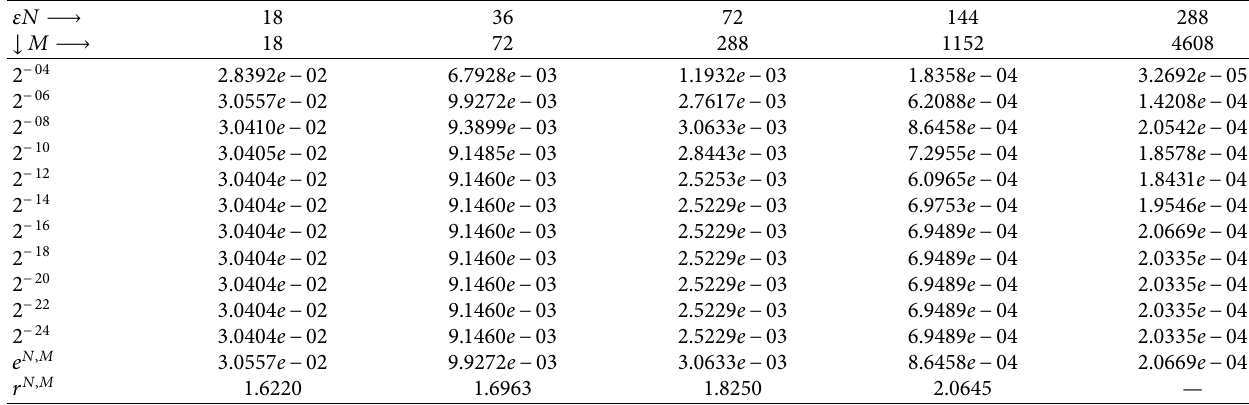
Table 2: Maximum absolute error and rate of convergence for Example 2.